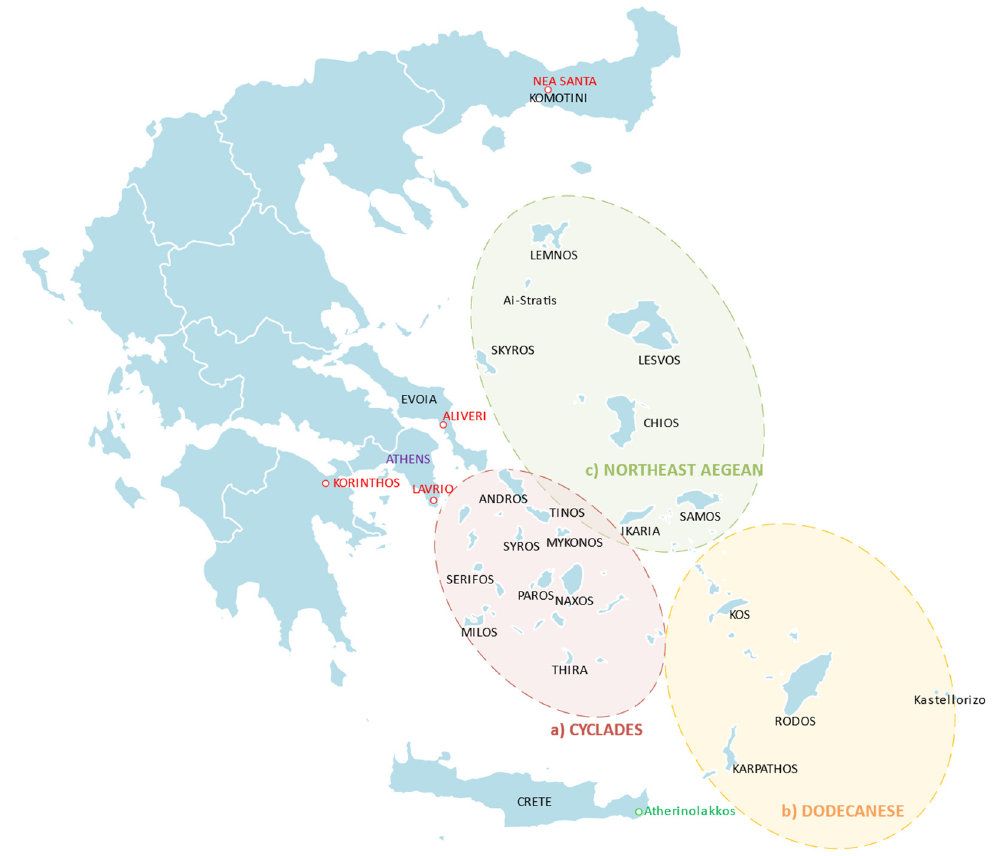
Figure 2. Map of island clusters: ( a ) Cycladic, ( b ) Dodecanese, and ( c ) Northeast Aegean Islands. Connection points are noted: Nea Santa, Aliveri, Lavrio, and Korinthos Extreme High Voltage Centers (EHVC) on the mainland as well as Atherinolakkos SS on Crete (under interconnection).